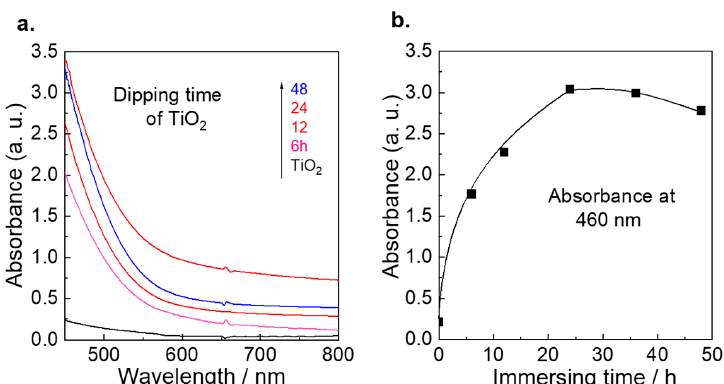
Figure 1. ( a ) UV–Vis spectral change of the Sb 2 S 3 /TiO 2 at difference time for dipping; ( b ) Plots of Absorbance vs. immersion time for Sb 2 S 3 /TiO 2 , respectively.